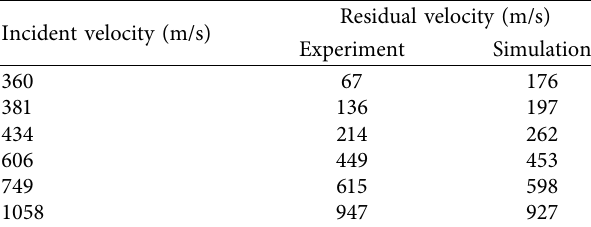
Figure 2: The finite element model of concrete Table 1: Comparisons of residual velocity between experiment and simulation.